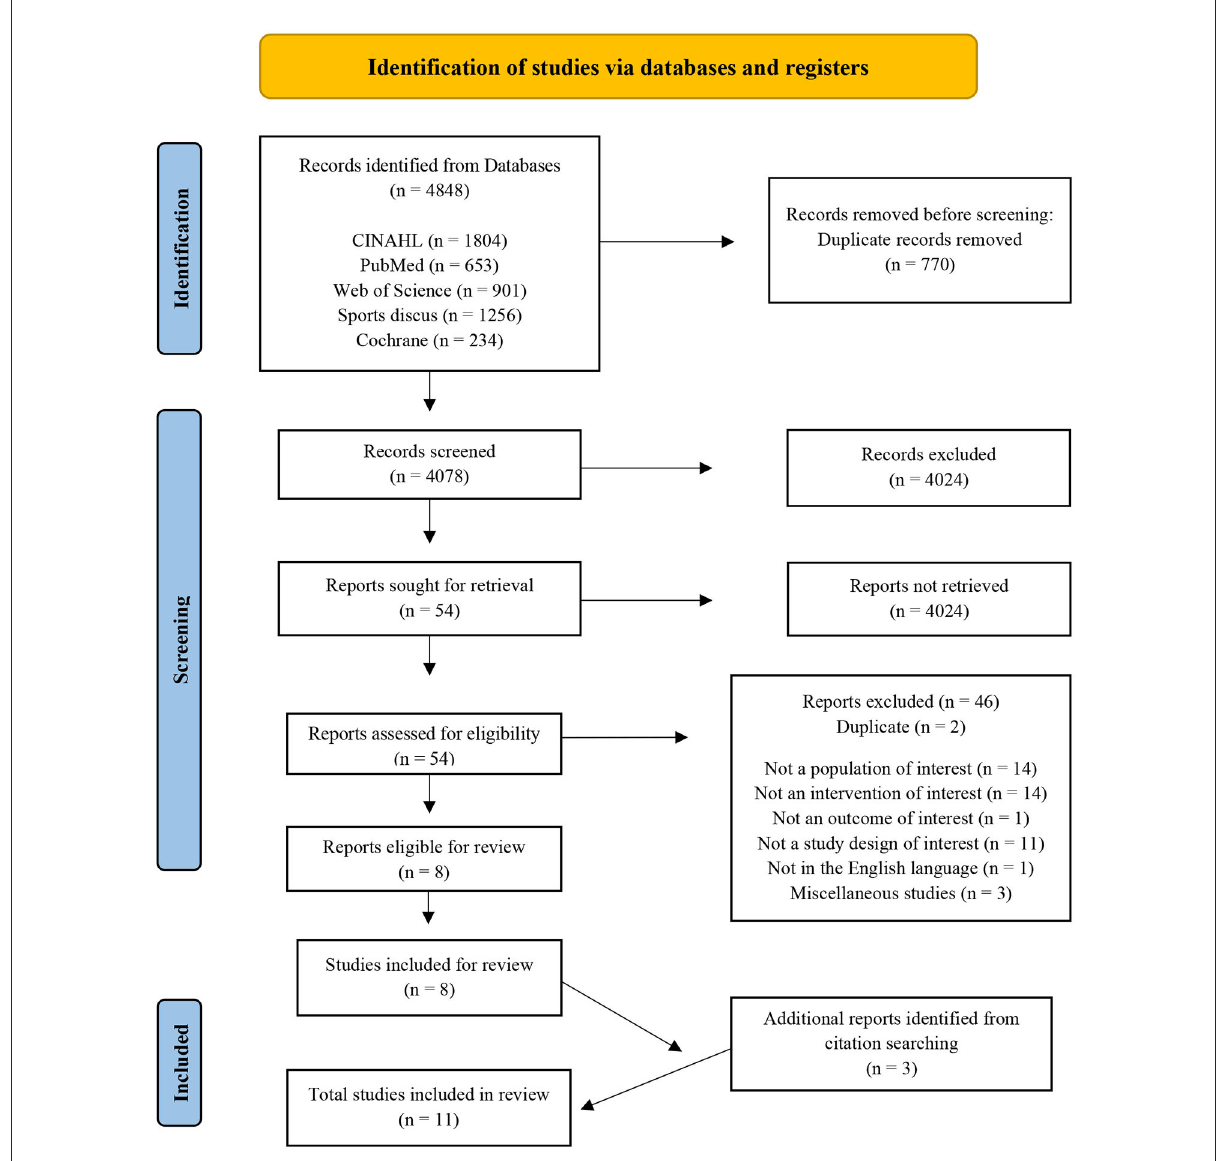
FIGURE1 Preferred Reporting Items for Systematic Reviews and Meta-analysis flow diagram of the studies included in the review (48).